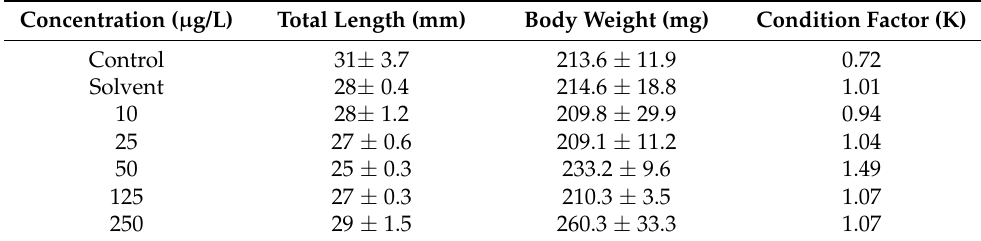
Table 1. Morphometric and condition factor of Javanese medaka (n = 3) at 21 days post-exposure